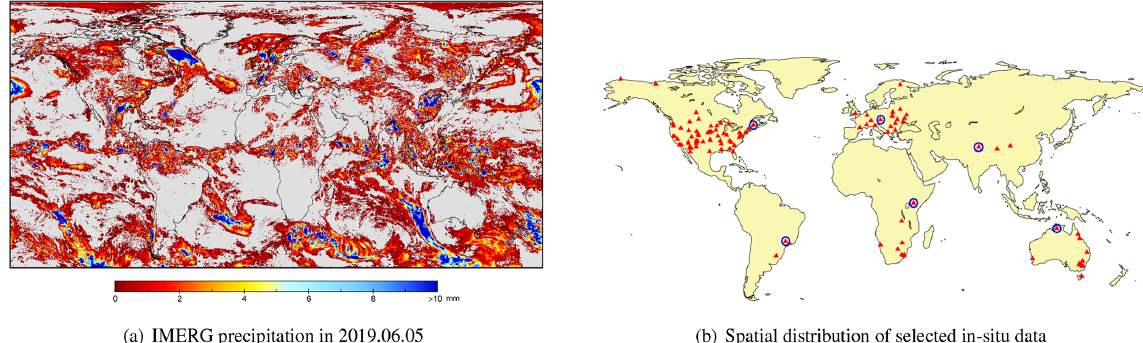
Figure 3. IMERG global daily precipitation and selected in situ data.